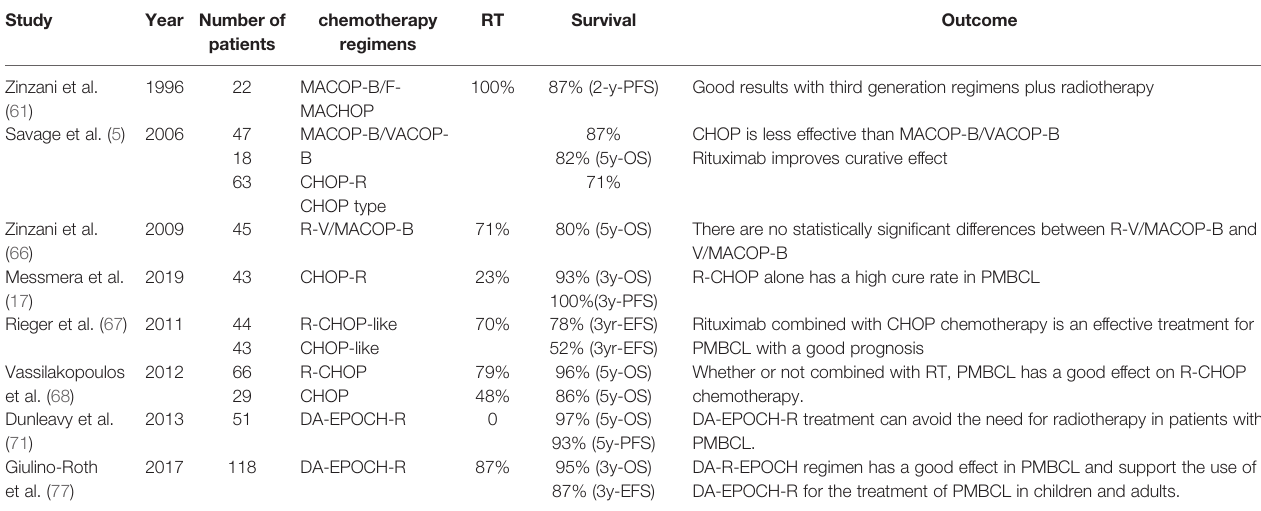
TABLE 2 | Results of chemotherapy data for primary mediastinal large B-cell lymphoma reported in various studies.